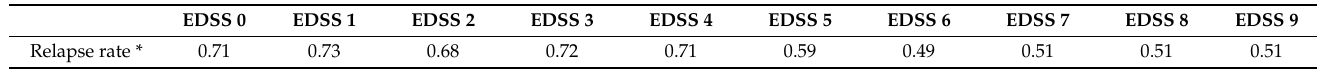
Table A3. Annual Natural History Relapse Rate by EDSS Health State Used in the Model.